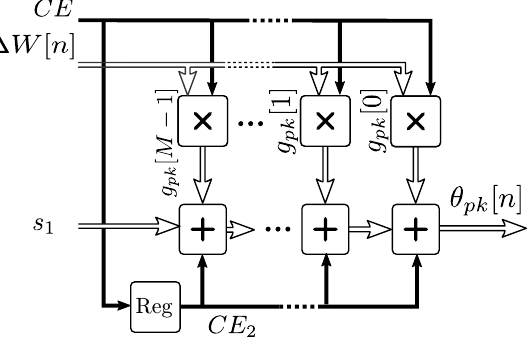
Figure 7. First segment implementation as a transposed FIR filter.